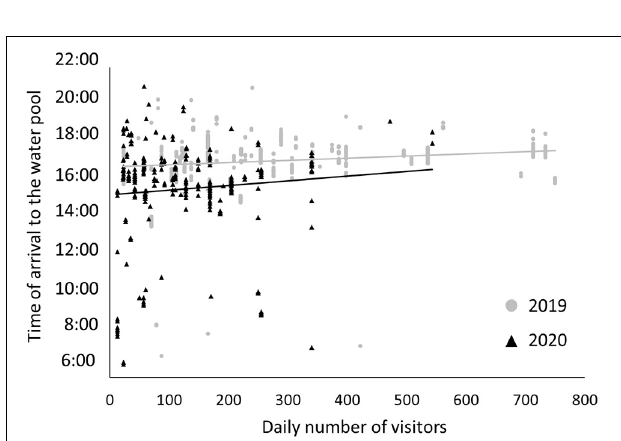
FIGURE 3 | The daily time curve of arrival of ibex to the water pools in Ein-Avdat (A) and Ein-Shaviv (B) during the beginning of the summer in 2019 (gray line) and 2020 (black line). The original records of the data are shown at the foot of the charts as rugs.